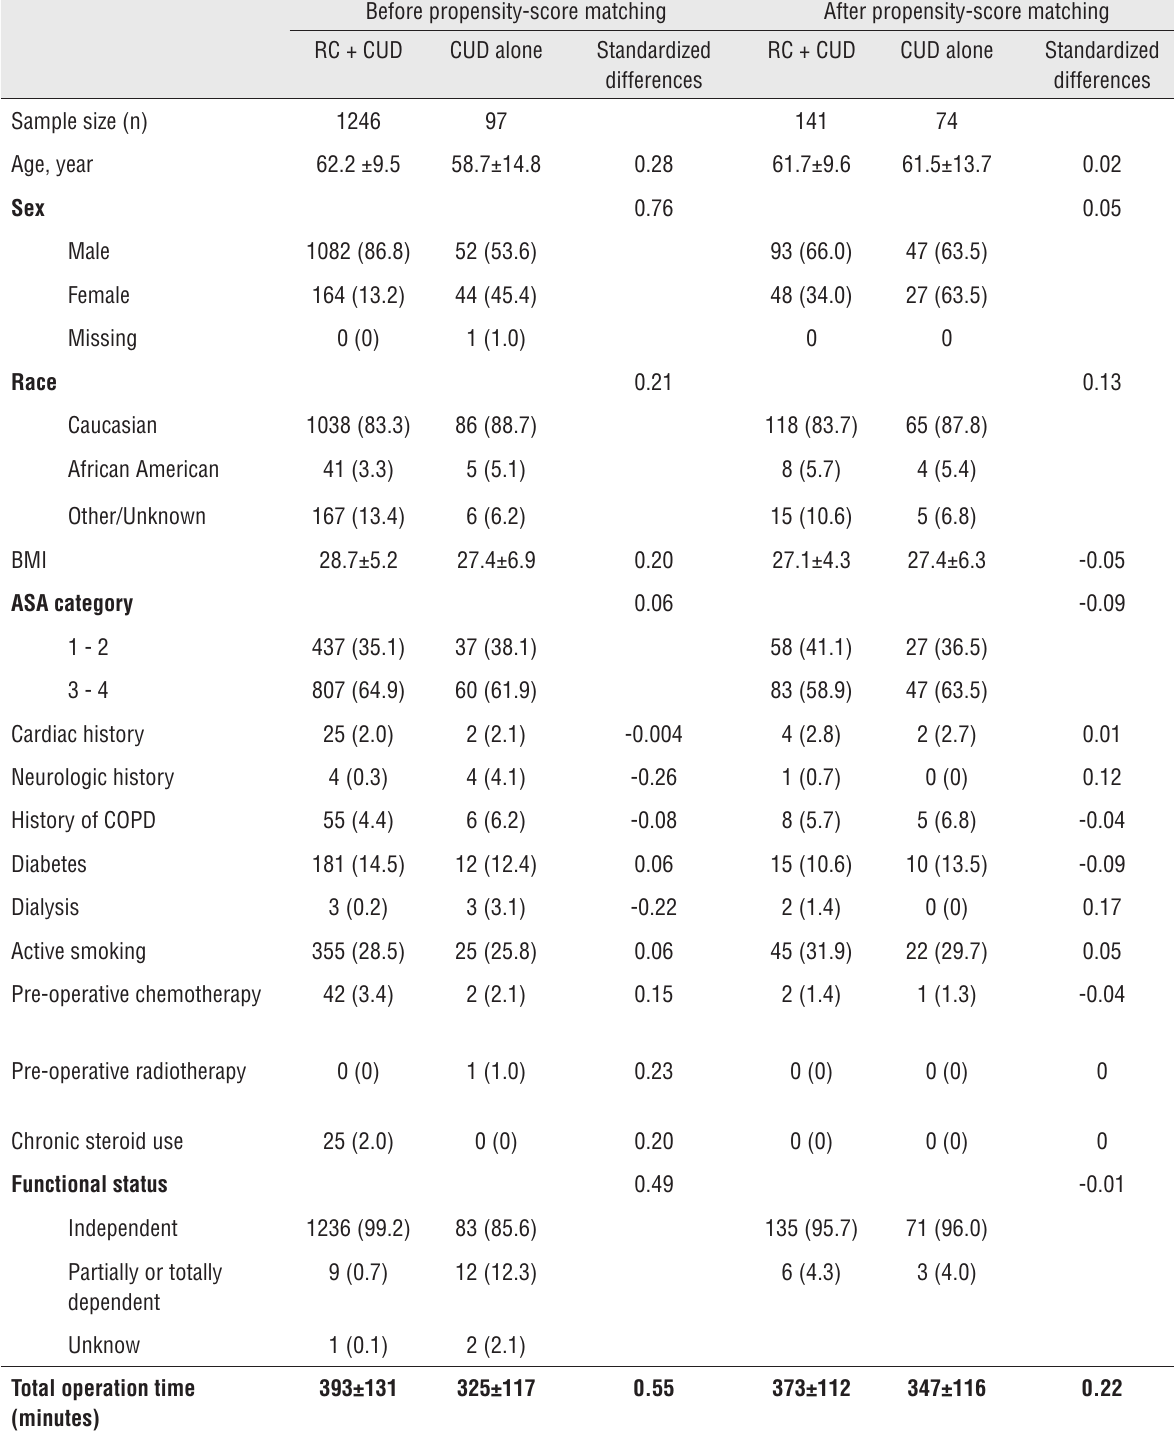
Table 2 - Baseline characteristics of patients before and after propensity-score matching for RC + CUD vs CUD alone. Before propensity-score matching After propensity-score matching RC + CUD CUD alone Standardized RC + CUD CUD alone Standardized differences